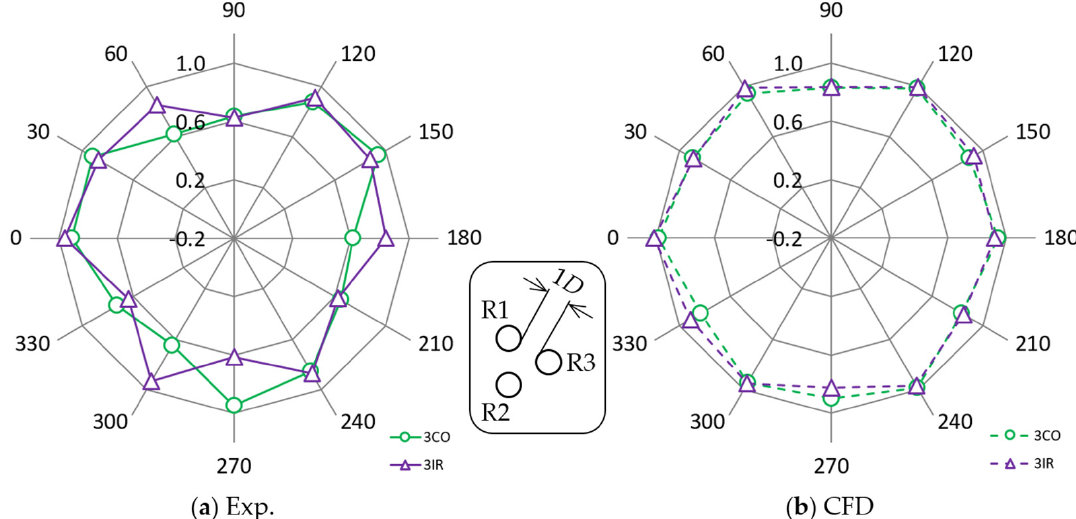
Figure 21. Comparison between 3CO and 3IR configurations on the average normalized rotational speed in a trio of VAWT models at g / D = 1: ( a ) experimental results; ( b ) CFD results.